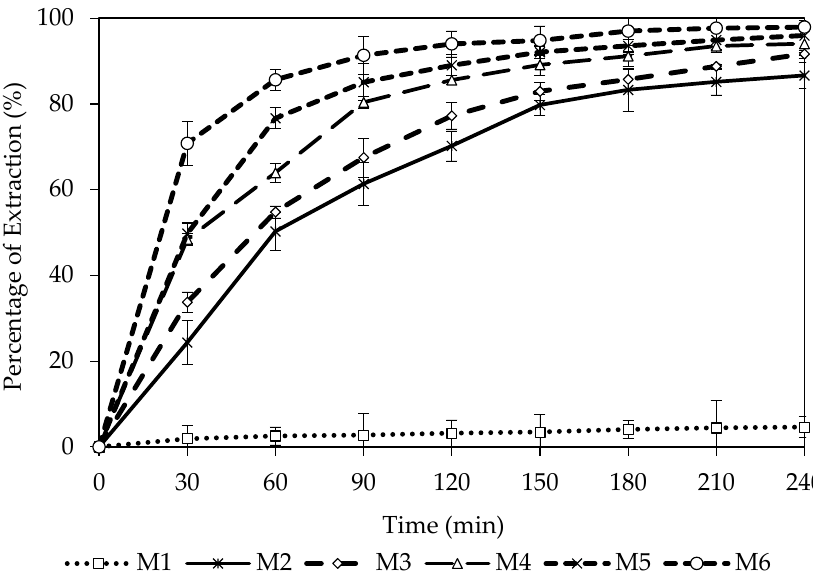
Figure 5. Percentage of extraction of M1, M2, M3, M4, M5 and M6. Table 3. Influence of the percentage of the carrier on permeability ( P ) and flux ( J ) of the mem- brane.